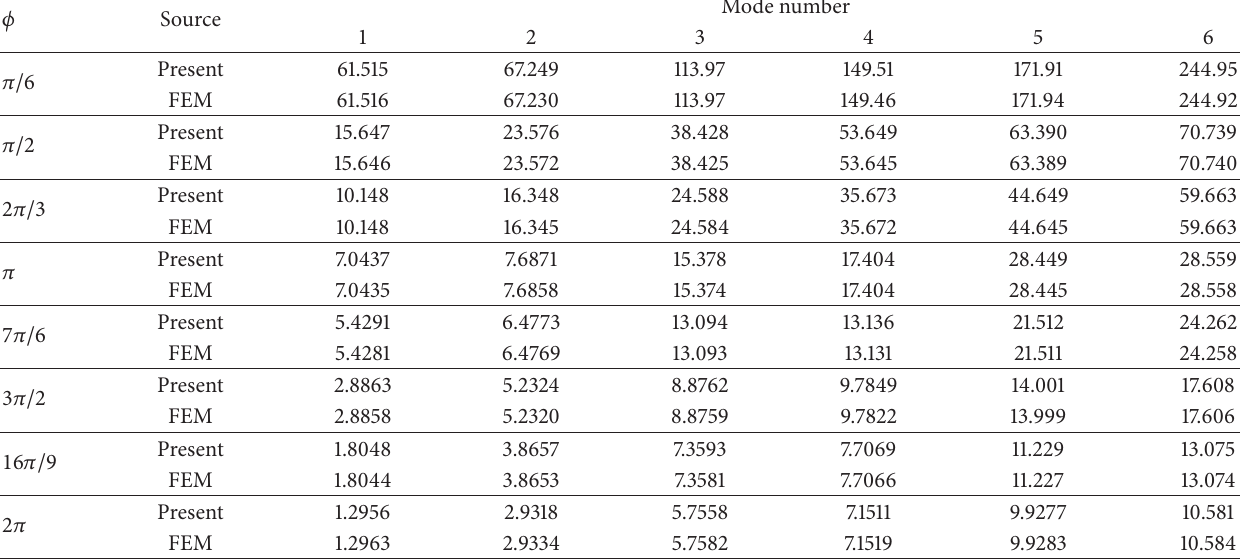
Table 3: Frequency parameters, Ω = 𝜔𝑏 2 (𝜌ℎ/𝐷) 1/2 , for completely free annular sector plates ( 𝑎/𝑏 = 0.4 and 𝜇 = 0.3